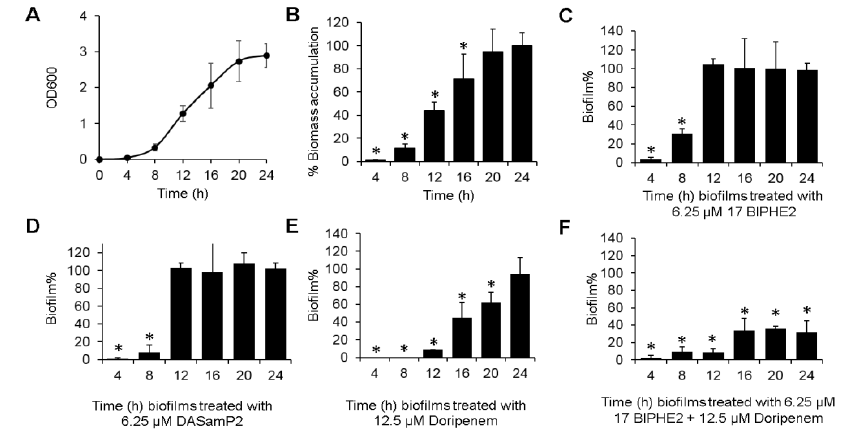
Figure 6. Real time biofilm formation and treatment of P. aeruginosa PAO1. Biofilm formation followed